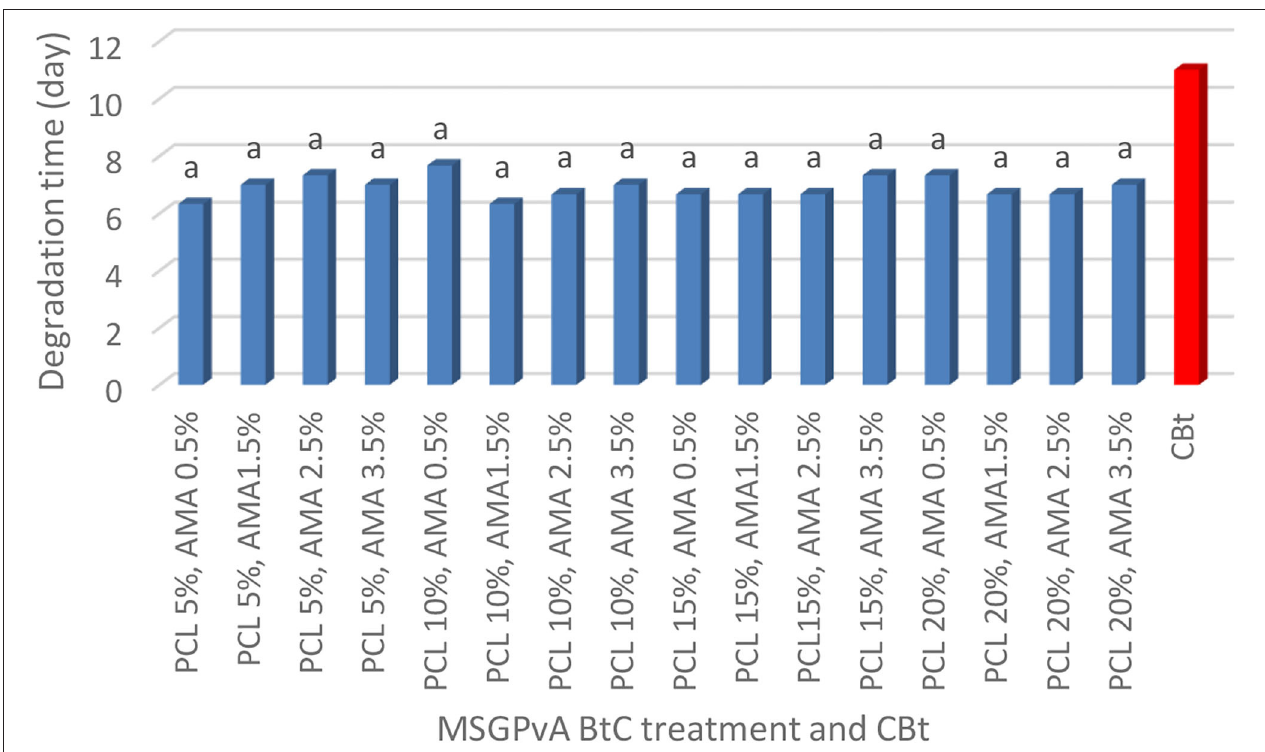
FIGURE 6 | Relationship of MSGPvA BtC and CBt with degradation time.